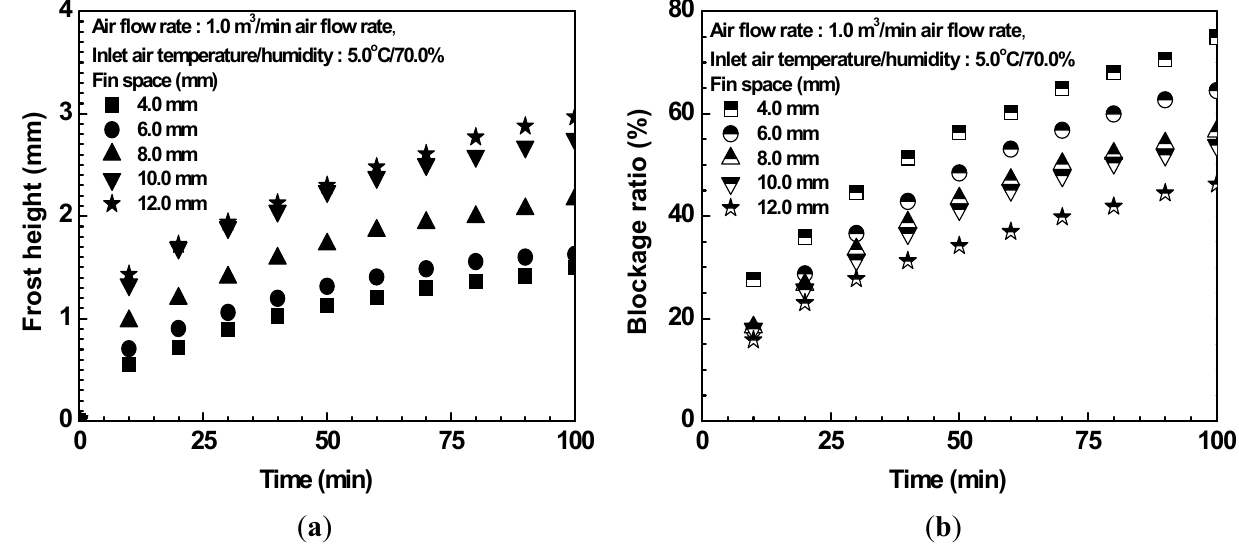
Figure 4. Frost height with variation of the fin space. ( a ) Frost height; ( b ) Blockage ratio.